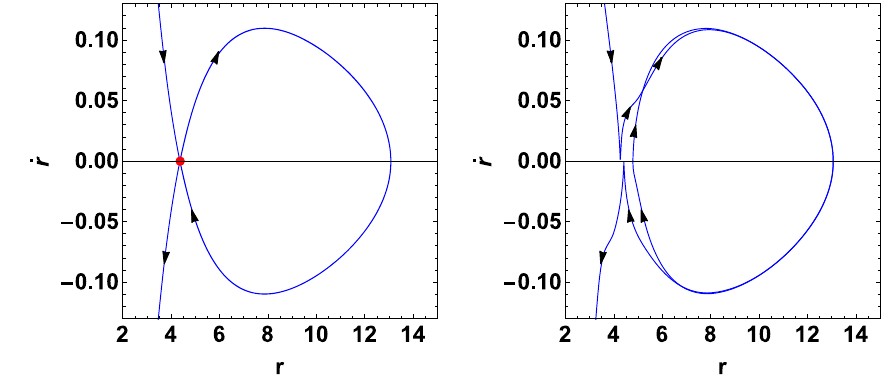
particle is shown in Fig. 3, which can be obtained with the parameters { E = 0 . 95, L = 2 . 4 M , a = 0 . 8, α = 0 } and the initial conditions { r ( 0 ) = 9 . 238142, ˙ r ( 0 ) = 0, θ( 0 ) = π For this orbit, the radial coordinate r (τ) is fixed, but the polar angle θ(τ) changes periodically with the affine parameter τ